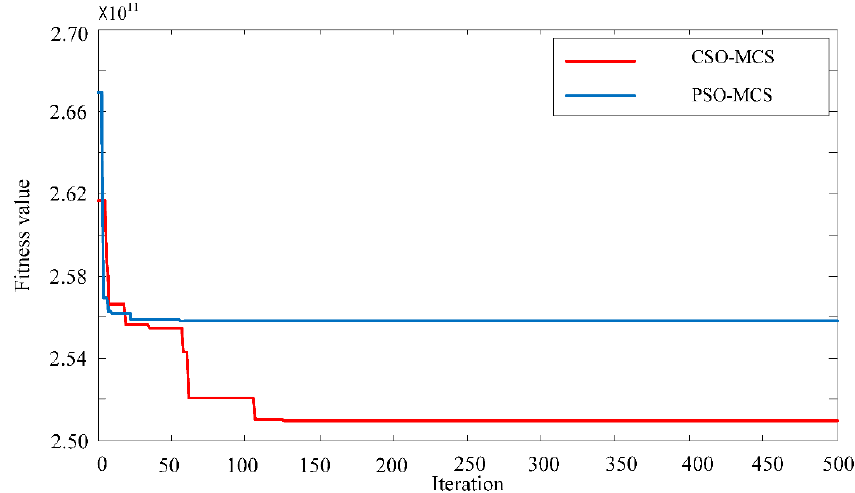
Figure 3. Convergence characteristics of CSO ‐ MCS and PSO ‐ MCS (Case 1).